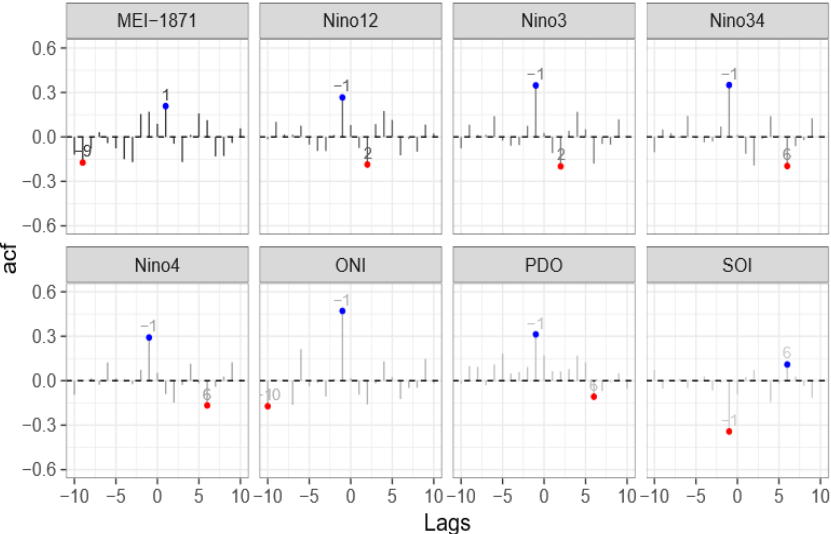
Figure 8. Sample cross-correlation functions between the PDSI series and all ENSO indices shown in Figure 7. Numbers indicate the associated lag at the peak value.